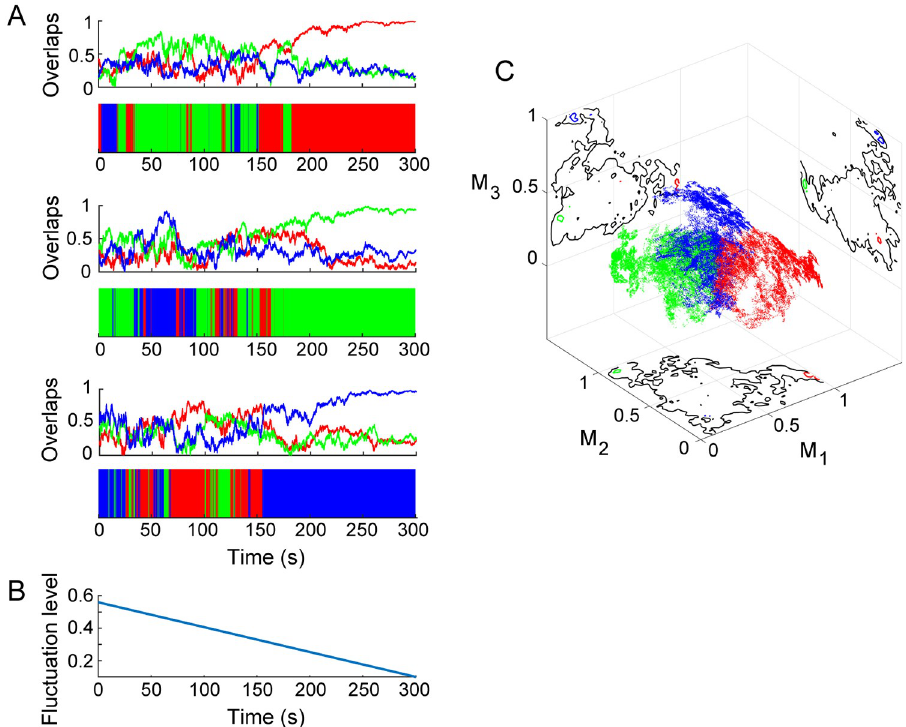
Fig 9. Shrinking of the simulated delta-alpha PAC dynamics with a temporally decreasing fluctuation level in the phase space: The qualitative change from the transition dynamics to the dynamics in a single state. (A) Time courses of the overlaps with their labeled sequences under different initial conditions in cases where the dynamics can converge into one of three states. (B) The time course of the fluctuation level. (C) The trajectories of overlaps in the phase space with their projections. The contour plots on projections in panel C indicate that the spaces filled by transition dynamics (black lines) can include the three states (red, green, and blue lines) as their subsets. The data used in this Figure correspond to the individual with higher attention-related AQ subscores depicted in Figs 3A to 3D(i), 4A to 4E, 7 and 8A to 8D.